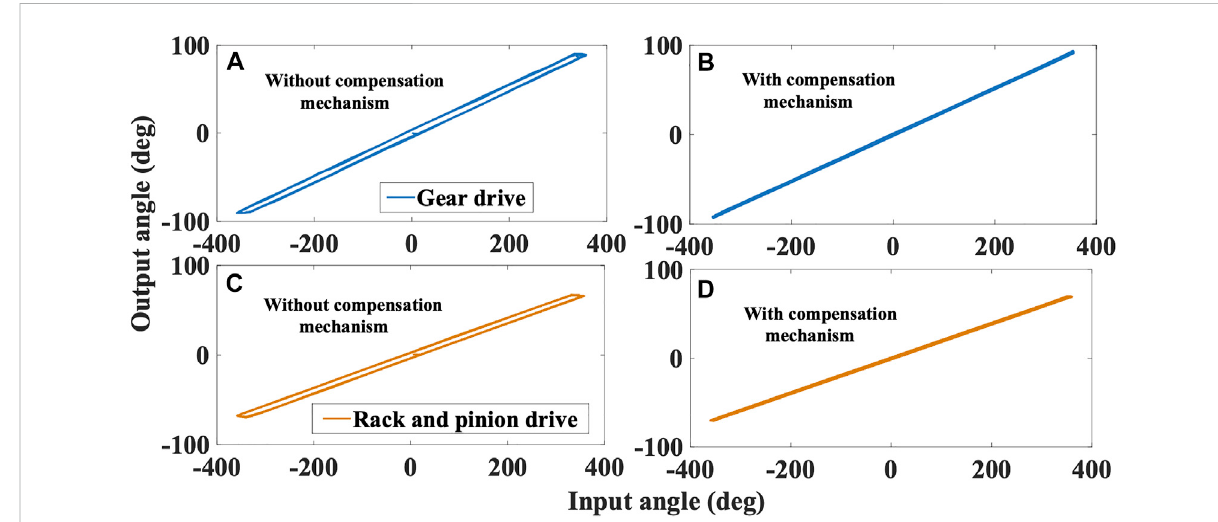
FIGURE 6 Backlash measurement with input-output hysteresis phenomenon for gear drive, and rack and pinion drive with/without compensation mechanism. (A) Gear drive without compensation (B) Gear drive with compensation (C) Rack and pinion drive without compensation (D) Rack and pinion drive with